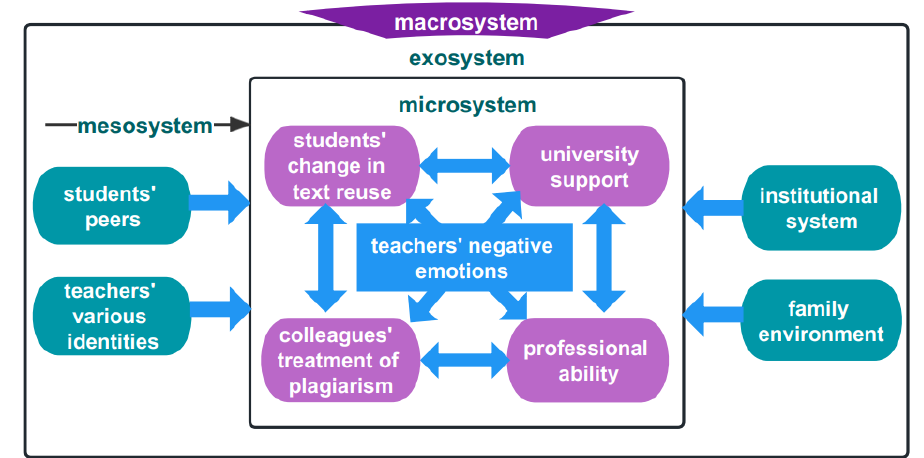
Figure 1. Teachers’ negative emotions within ecological systems.